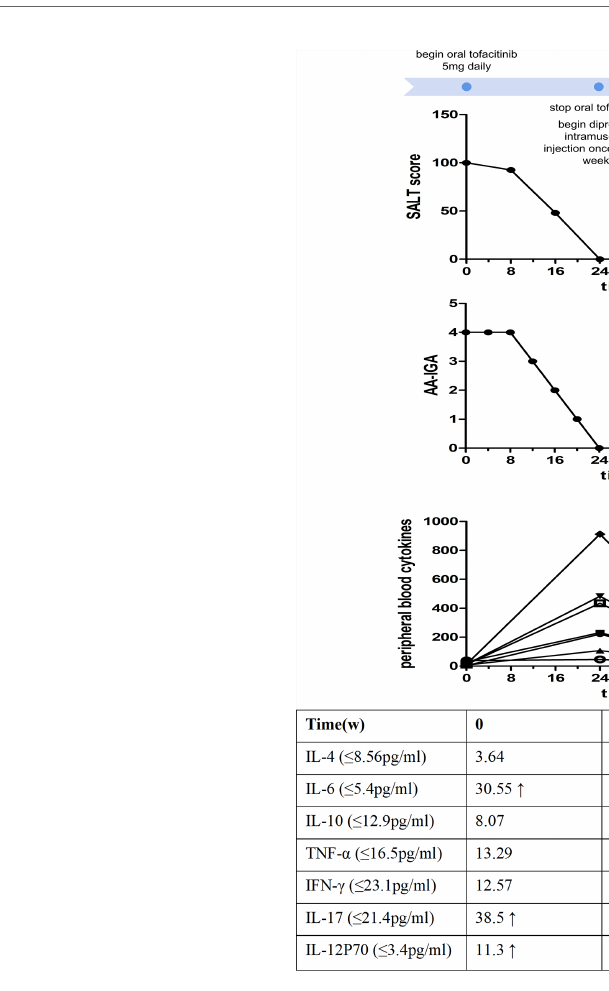
FIGURE 2 | Time course of the treatment and changes in the Severity of Alopecia Tool (SALT) score, the Alopecia Areata Investigator Global Assessment (AA- IGA ™ ), and the levels of peripheral blood